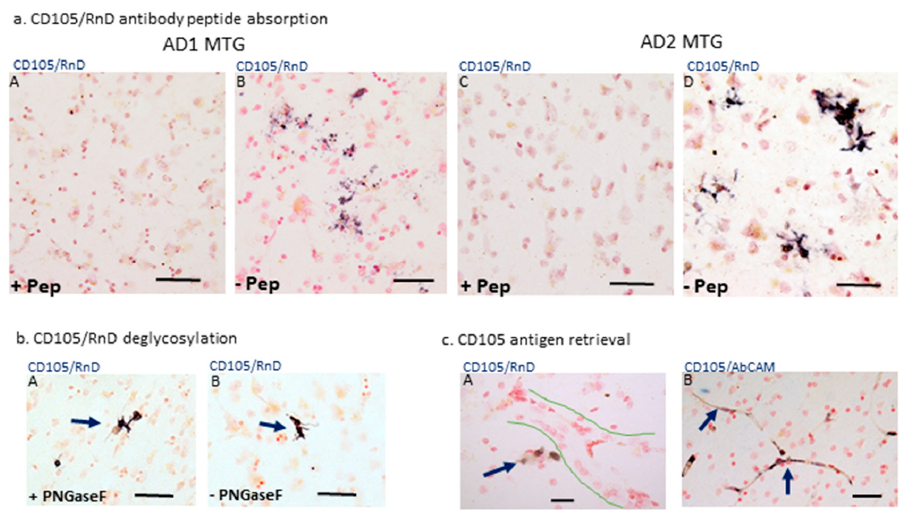
Figure 3. Absorption controls for CD105 staining of microglia and antibody characterization. ( a ) Antibody absorption. (panels A–D). Staining of sections from AD cases (AD1) (A and B) or AD2 with CD105 antibody preabsorbed with immunizing peptide ( + Pep) compared to staining of matched sections with CD105 antibody non-absorbed ( − Pep). All images are at same magnification: scale bars represent 50 µ m. ( b ) Deglycosylation. Tissue section (AD case) was treated with PNGase F in solution ( + PNGase F) (panel A) or underwent control treatment without enzyme ( − PNGase F) (panel B), and then reacted with CD105 / RnD antibody. Images are at same magnification: scale bars represent 50 µ m. ( c ) Antigen retrieval. Tissue sections from an AD case underwent antigen retrieval procedure prior to immunocytochemistry with antibodies CD105 / RnD (panel A) or CD105 / AbCAM (panel B). The position of an unstained large vessel is outlined (panel A). Vessel staining indicated with purple arrows (panel B). Scale bars represent 50 µ